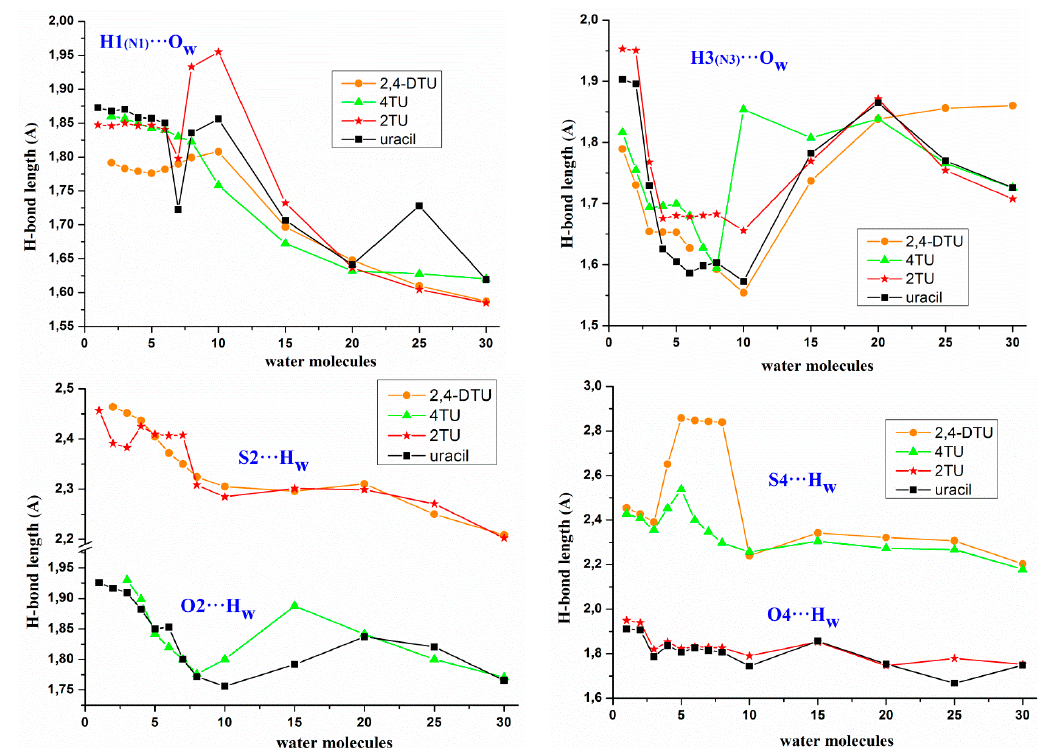
Figure 3. Comparison of the intermolecular H-bond lengths between uracil / 2-thiouracil / 4-thiouracil / 2,4-dithiouracil molecules versus the water molecules number with the progress of the hydration up to 30 water molecules in the cluster surrounding the